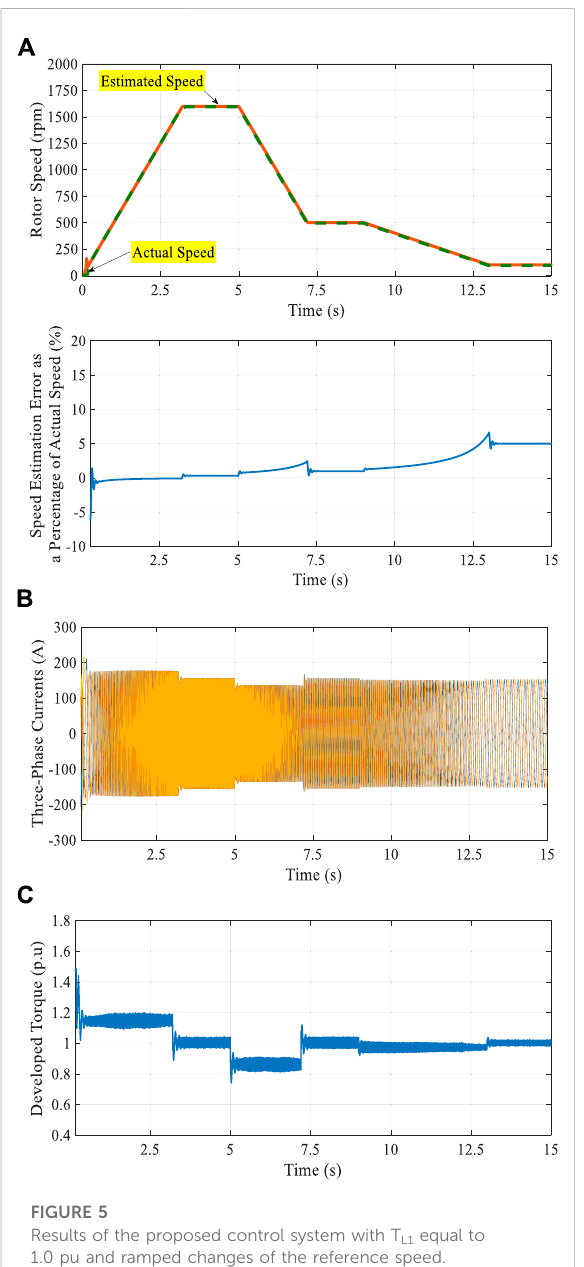
FIGURE 6 Results of the proposed control system with T L1 are stepped changed from 1.0 pu to 0.5 pu at a time equal to 3.0